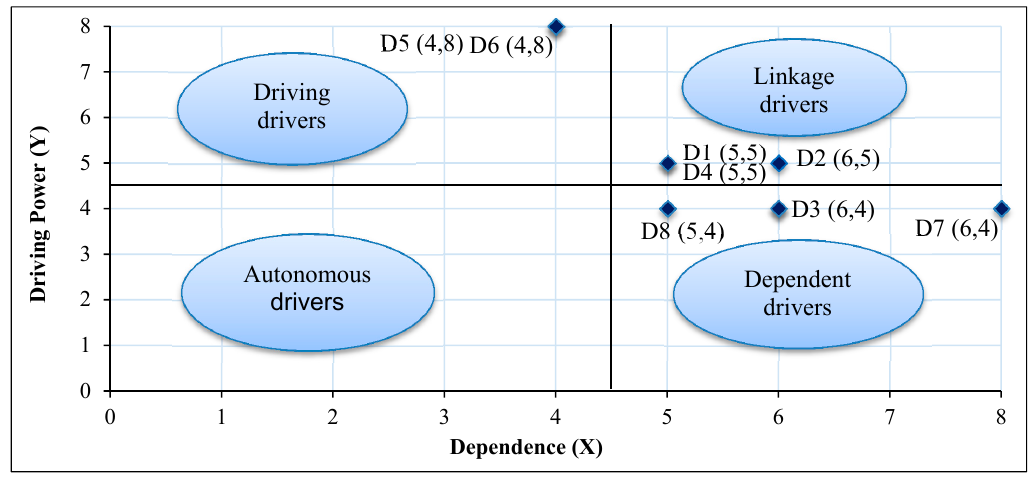
Figure 6. Directed graph and MICMAC analysis of the drivers of